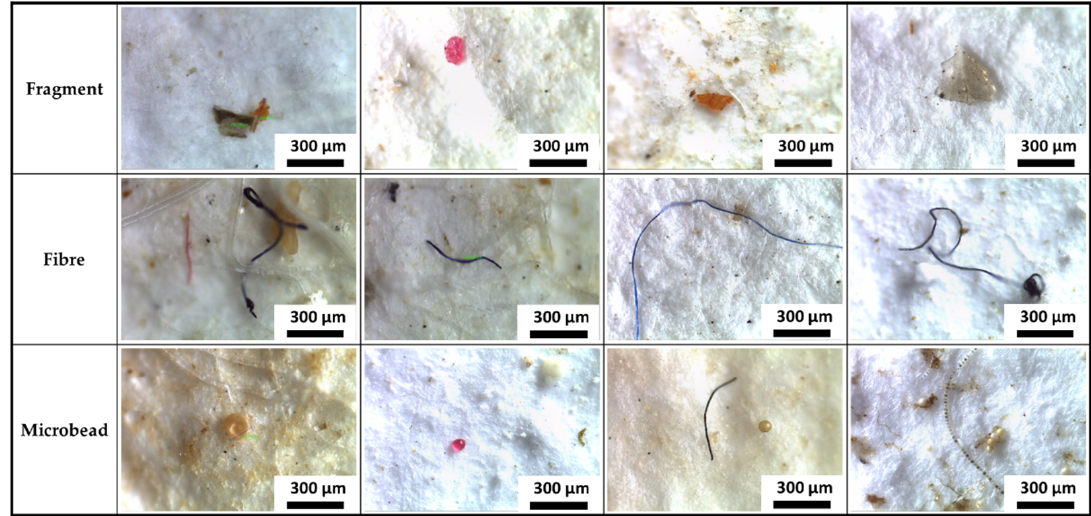
5 of 13 Figure 2. Removal of microplastic in different treatment processes. ( A ) Percentage of microplastics removed at samping point; ( B ) Overall percentage of microplastic removal. Among related studies, the microplastic concentration varies from influent to efflu- ent. Some studies showed high microplastics concentration in influent (2223–10,044 MP/L) and effluent (29–447 MP/L), meanwhile low microplastic concentration were also found in influent (1 MP/L) and effluent (0.00088 MP/L) [22,30]. These results are caused by dif- ferent sampling techniques, identification methods, and technology applied in every WWTP [23]. For example, the filter paper pore size used to capture the microplastic from the sample is different and often varying [30–33]. Currently, no standard method for mi- croplastic analysis exists from the beginning to the end; therefore, it is necessary to stand- ardize the procedures of research on microplastic. Several factors such as differences in population density, local/regional development area, and catchment area also affect the microplastic emissions in an area. Although in general, there is a positive correlation be-